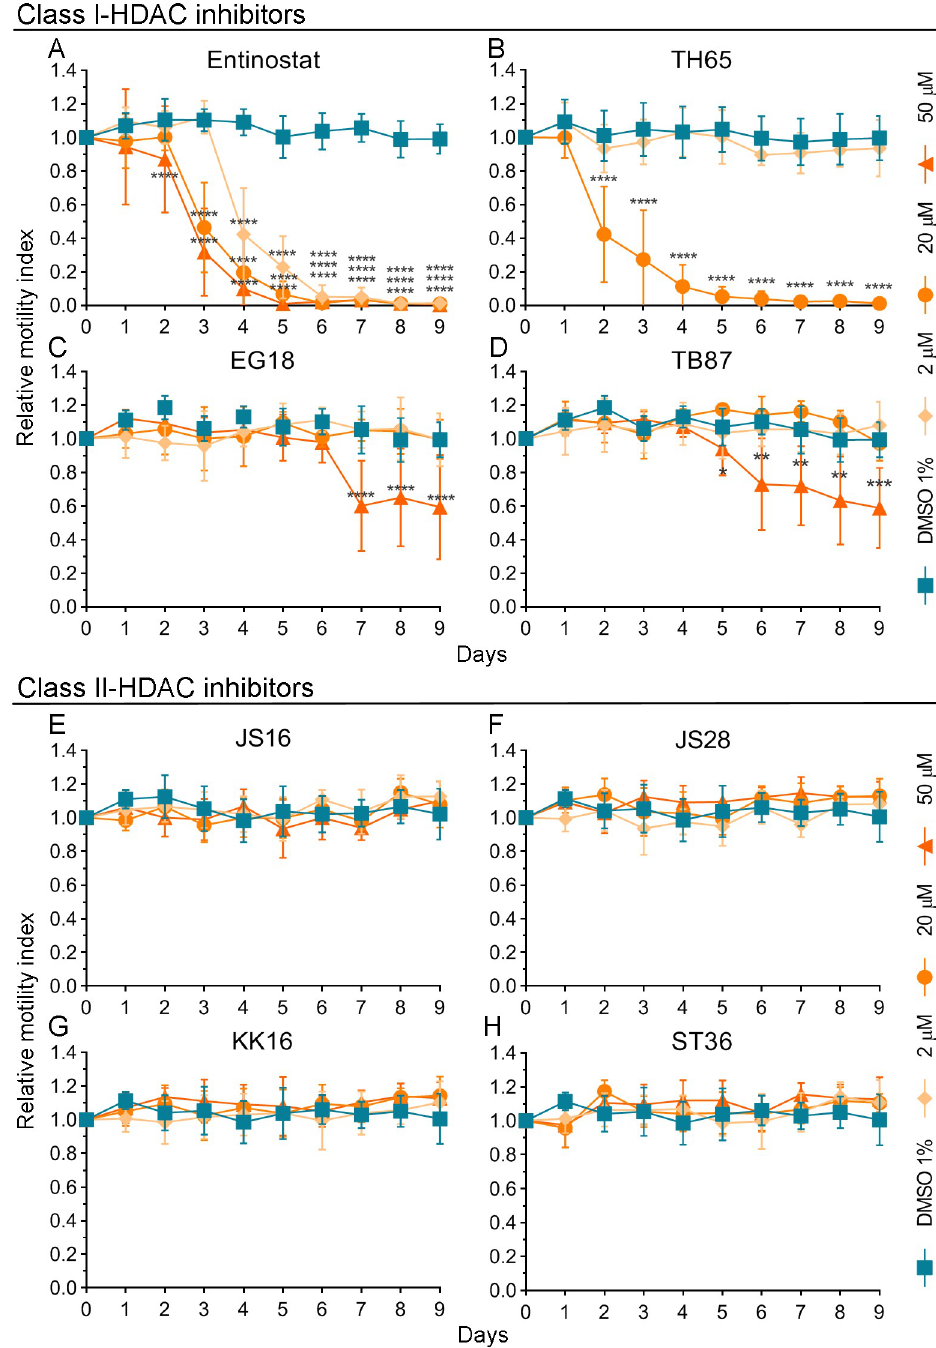
Fig 1. Effect of Class I- and Class II-HDAC inhibitors on Mesocestoides vogae TTy (tetrathyridia) viability. In vitro anthelmintic activity was determined for the Class I-HDAC inhibitors: (A) entinostat, (B) TH65, (C) EG18, and (D) TB87; and the Class II-HDAC inhibitors: (E) JS16, (F) JS28, (G) KK16, and (H) ST36. The compounds were evaluated at concentrations of 2, 20 and 50 μ M (TH65 was not evaluated at 50 μ M due to low solubility) and at different incubation times, using the M . vogae TTy motility assay. Parasites incubated with the drug vehicle (DMSO 1%) were used as a negative control. Relative motility indices were measured from three independent biological replicates, each one in quadruplicate. Error bars represent the standard deviation and the asterisks indicate those values that showed differences with statistical significance compared to the negative control, according to two-way ANOVA test and Dunnett’s post-tests ( � , p < 0.05; �� , p < 0.01; ��� , p < 0.001; ���� , p < 0.0001).